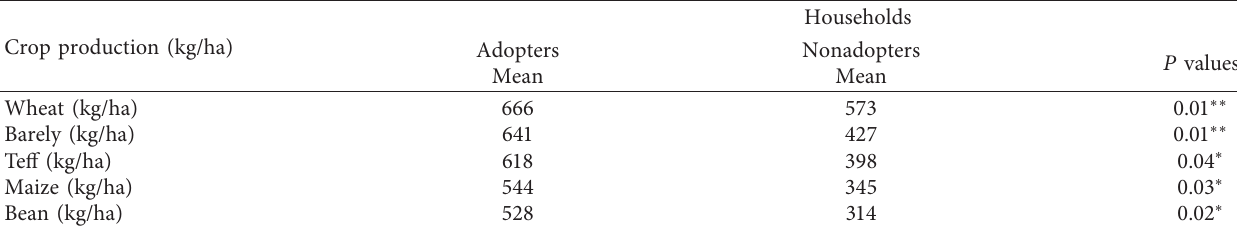
Figure 4: Bee production and women’s participation in Damota area districts. Table 4: Descriptive statistics for crop production in the study area.